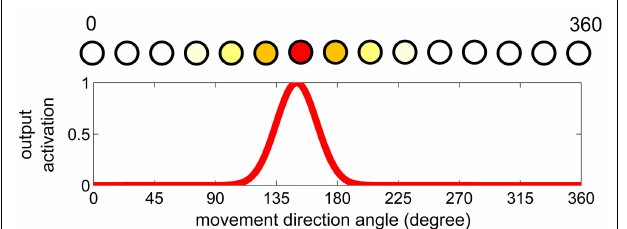
FIGURE 1 | Example of a dynamic neural field. The top graph shows the topological encoding of a movement direction in degrees of heading (0–360).The bottom graph illustrates a possible output activation (see also neuron colors in top graph) that could be the result of the neural field dynamics. In this particular case the output activation represents a movement heading of approximately 150˚ as the neuron corresponding to this direction has the highest output